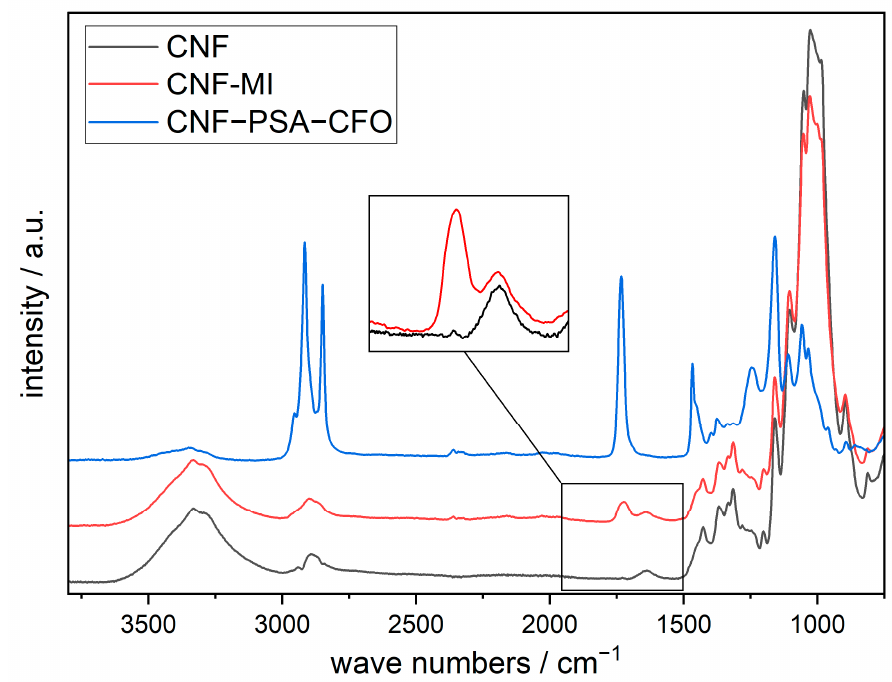
Figure 5. FTIR spectra of pristine CNF, CNF ‐ based macroinitiator (CNF ‐ MI), and poly(SA) ‐ grafted